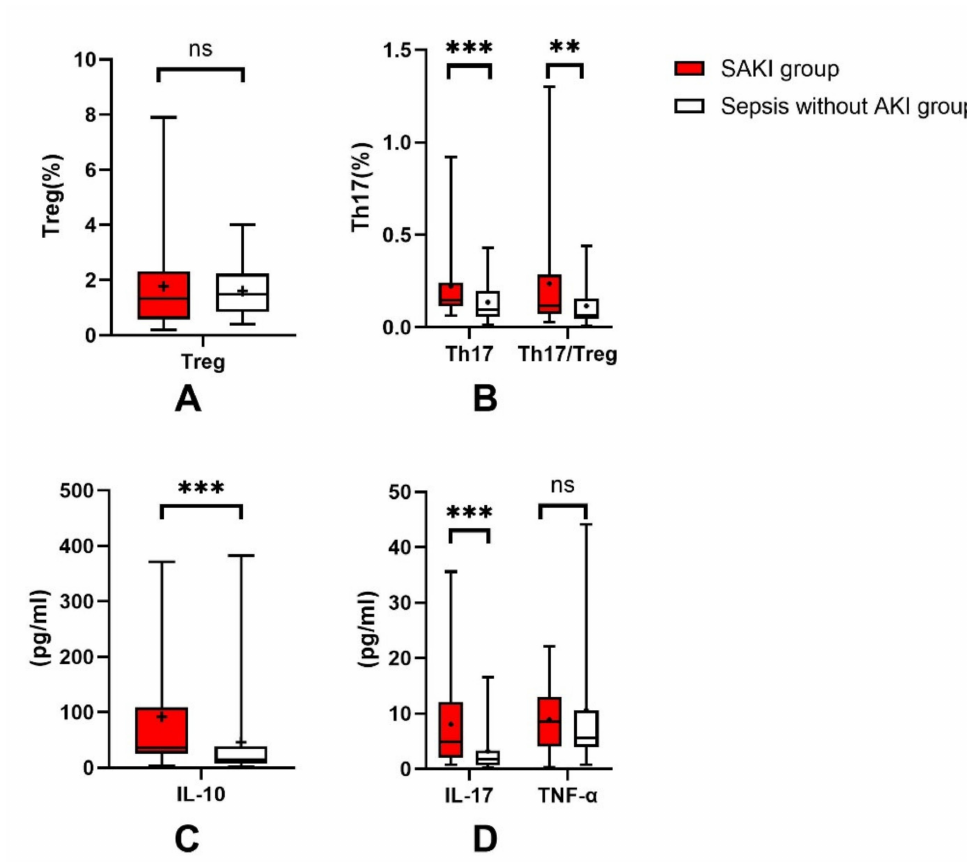
Figure 2. Treg ratio for SAKI group and sepsis-without-AKI group ( A ). Th17 ratio and Th17/Treg ratio for SAKI group and sepsis-without-AKI group ( B ). IL-10 level for SAKI group and sepsis- without-AKI group ( C ). IL-17 and TNF- α level for SAKI group and sepsis-without-AKI group ( D ). SAKI: sepsis-induced acute kidney injury; Treg, regulatory T cell; Th17, helper T cell 17; IL-10, Interleukin-10; IL-17, Interleukin-17; TNF- α , Tumor necrosis factor alpha; AKI, acute kidney injury. p value: ns > 0.05; ** 0.01–0.001; ***<